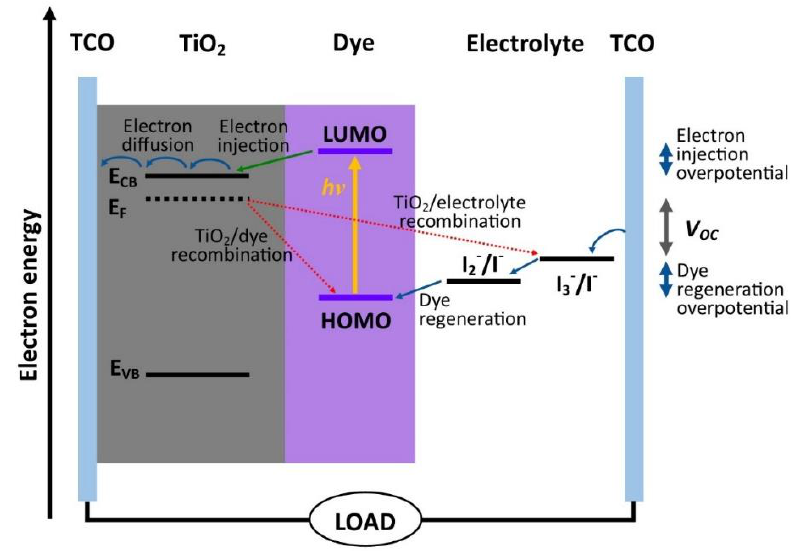
Figure 1. Schematic energy diagram and working mechanism of a DSC.